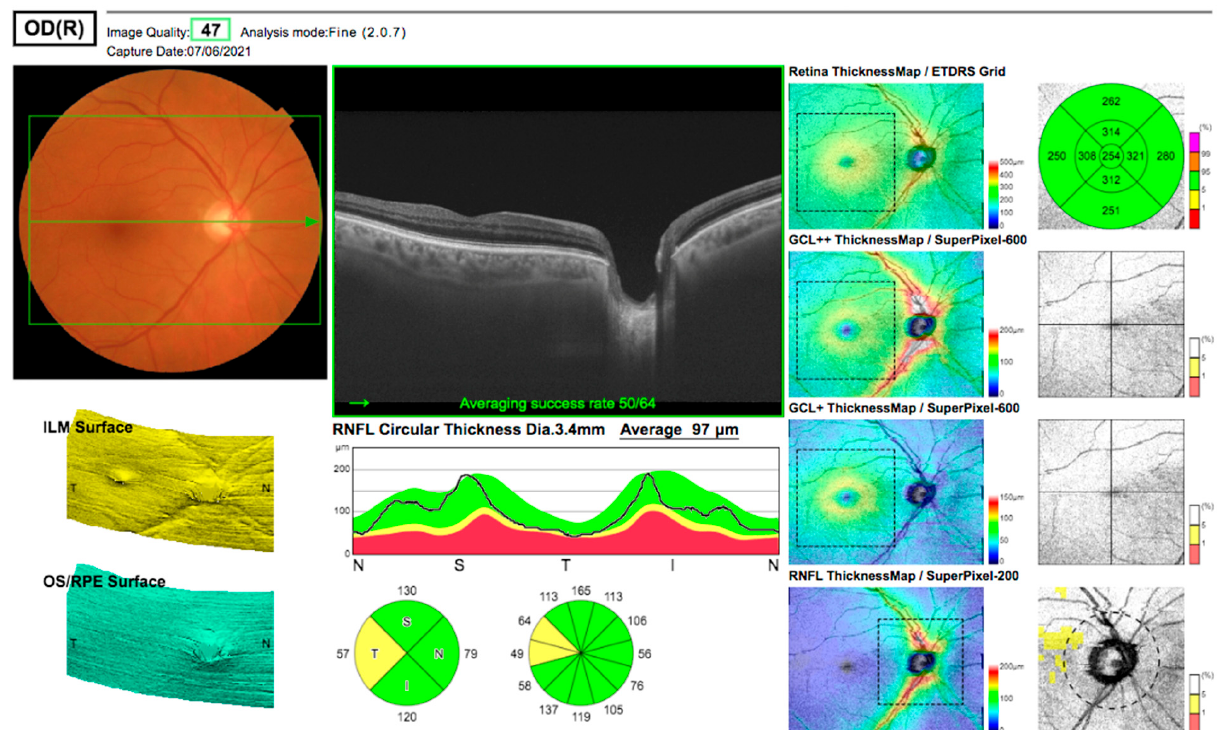
Figure 1. Preoperative OCT images taken on 7 June 2021. There is normal enhancement of the layers of the neural retina. Macular thickness is within the normal range .